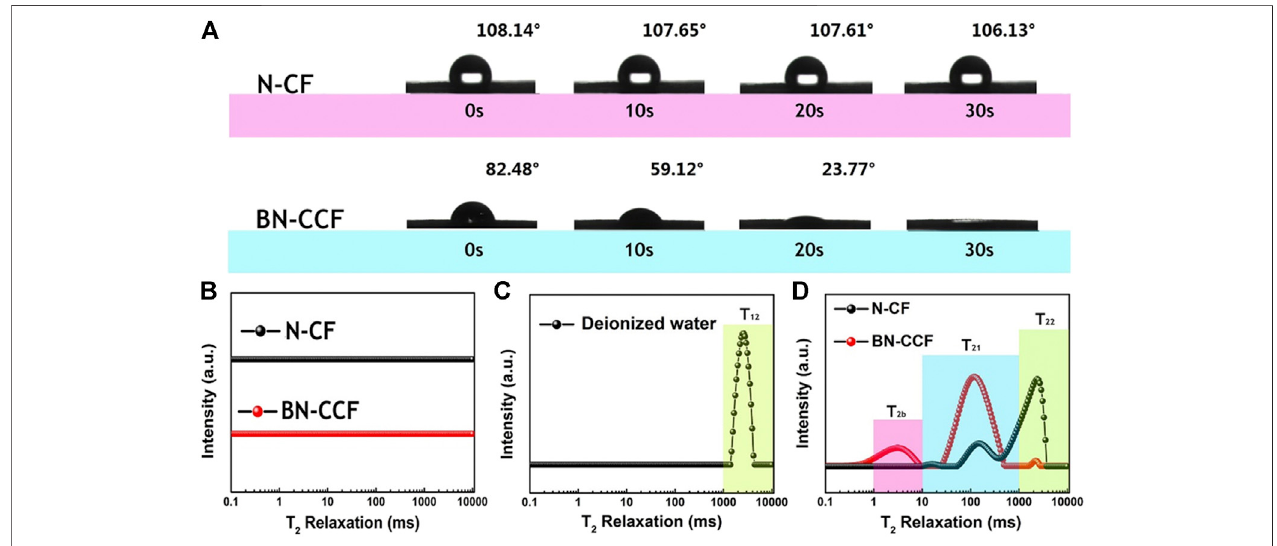
FIGURE 5 | (A) Photographs of dynamic contact angles for the water droplet on N-CF and BN-CCF. T 2 relaxation time distributions for (B) N-CF and BN-CCF (C) deionized water and (D) N-CF and BN-CCF mixed with deionized water.